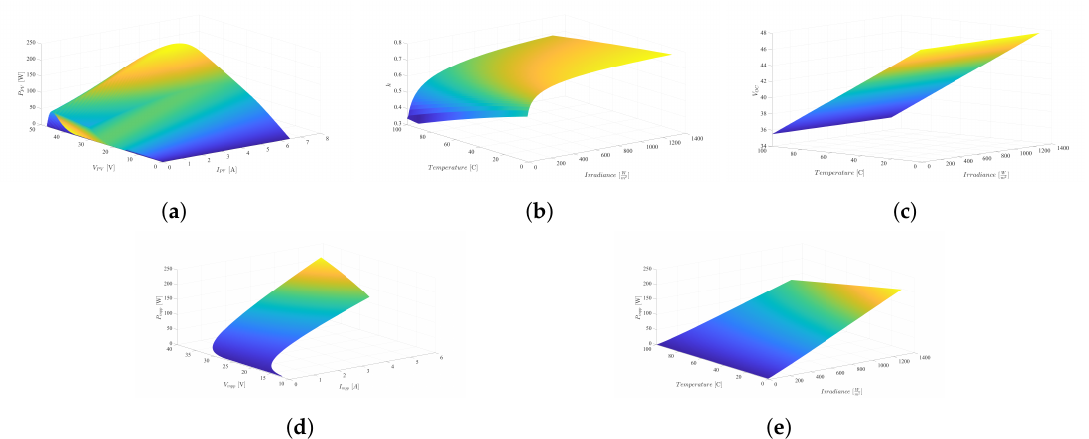
Figure 7. ( a ) The output power of the PV panel versus the PV current and PV voltage. ( b ) The ratio between the maximum voltage versus the irradiance and temperature. ( c ) The effects of solar irradiance and temperature on the open-circuit voltage of the PV panel. ( d ) The effects of solar irradiance and temperature on the maximum power of the PV panel. ( e ) The maximum power versus the maximum current and the maximum voltage of the